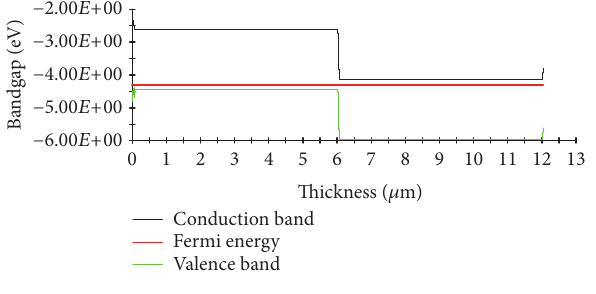
Figure 11: Band diagram of the proposed solar